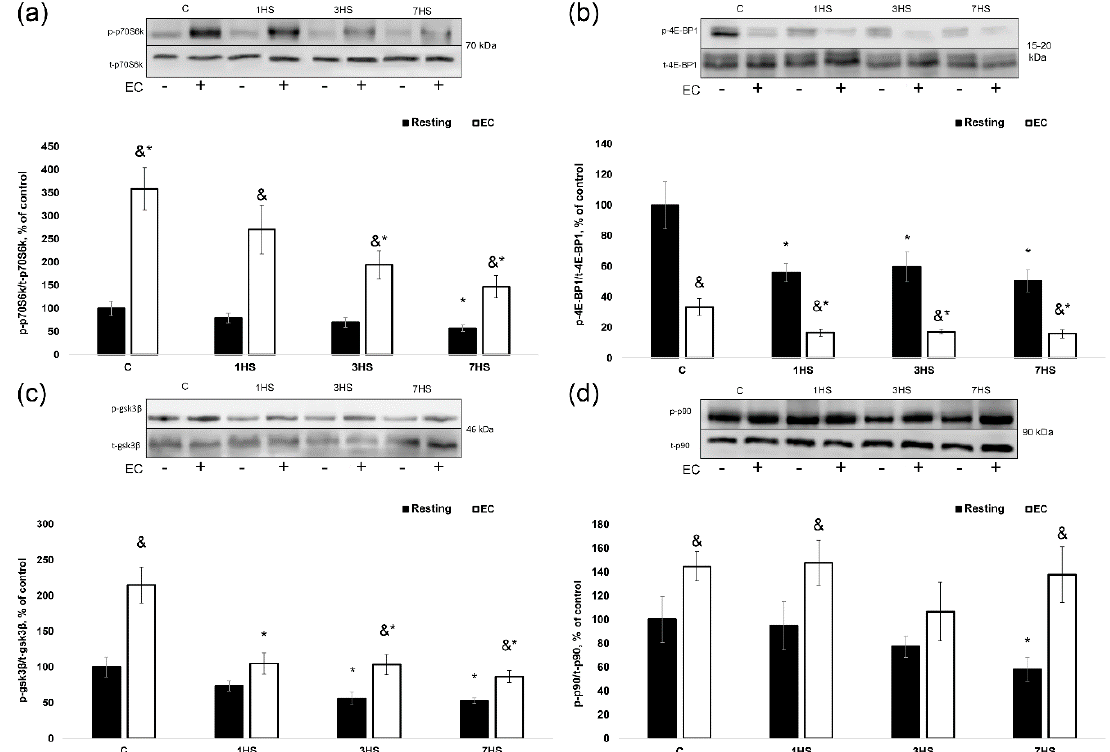
Figure 2. Phosphorylation status of the key anabolic signaling proteins in the eccentrically-contracted rat soleus muscles following hindlimb unloading (experiment 1). ( a ): p70S6K (Thr389) phosphorylation; ( b ): 4E-BP1 (Thr37/46) phosphorylation; ( c ): GSK-3 β (Ser9) phosphorylation; ( d ): p90RSK (Thr359/Ser363) phosphorylation. Values are means ± SEM, expressed relative (%) to the control resting muscle; n = 7/group. C—control rats, 1HS, 3HS and 7HS—hindlimb unloading for 1, 3 and 7 days. The data were analyzed using 2-way ANOVA with post hoc Tukey. p70S6K (Thr389) phosphorylation: the main effect of HS p = 9,18811E-06, the main effect of EC p = 1,34515E-13, interaction effect p = 0,003124; 4E-BP1 (Thr37/46) phosphorylation: the main effect of HS p = 0,000353, the main effect of EC p = 2,00982E-10, interaction effect p = 0,021799; GSK-3 β (Ser9) phosphorylation: the main effect of HS p = 1,01182E-08, the main effect of EC p = 5,21828E-08, interaction effect p = 0,005360; p90RSK (Thr359/Ser363) phosphorylation: the main effect of HS p = 0,125909, the main effect of EC p = 2,04532E-05, interaction effect p = 0,448363; *—significant difference vs. C group ( p < 0.05), &—significant difference from the resting muscle of the same group ( p < 0.05). Black bars—resting muscle, white bars—eccentrically-contracted muscle.